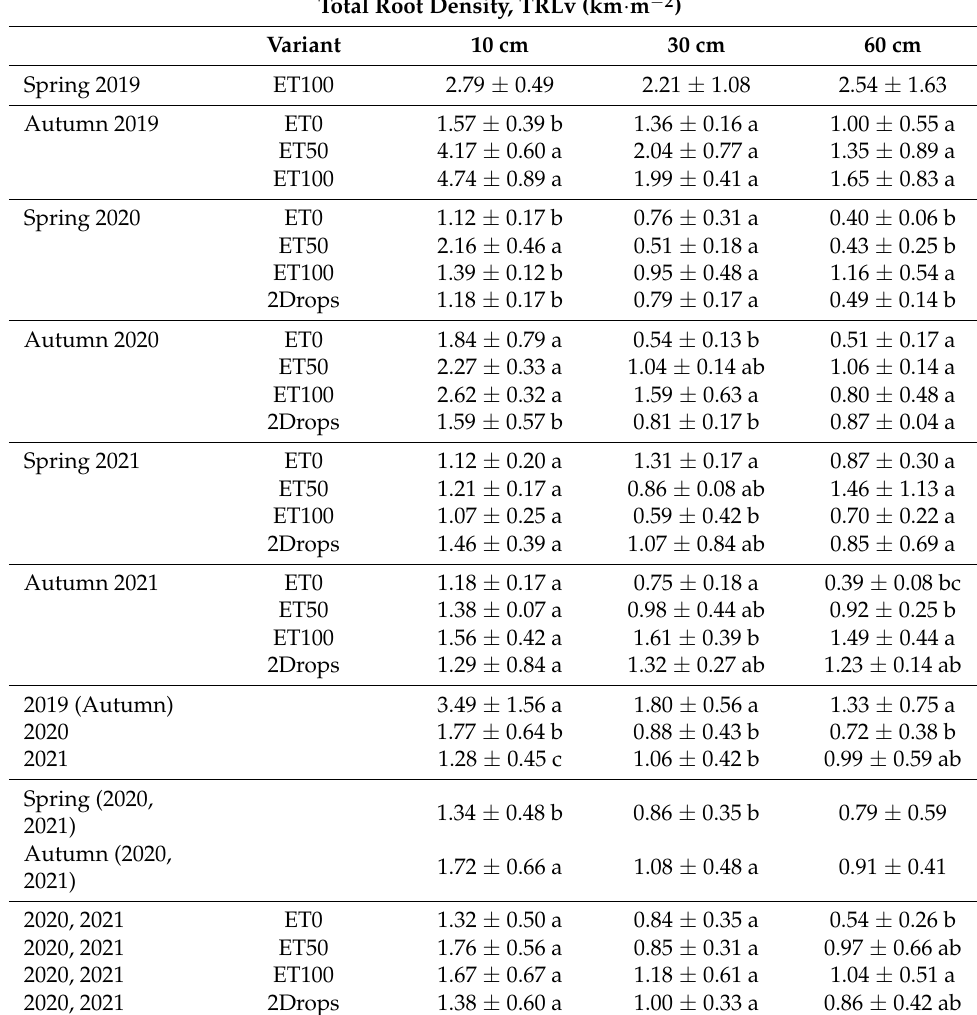
Table 4. Total root length of new vital roots to a depth of 80 cm (TRLv) at distances of 10 cm, 30 cm, and 60 cm from the tree trunk, in experimental years and variants. ET0, ET50, ET100, and 2Drops refer to irrigation water rate variants (see Figure